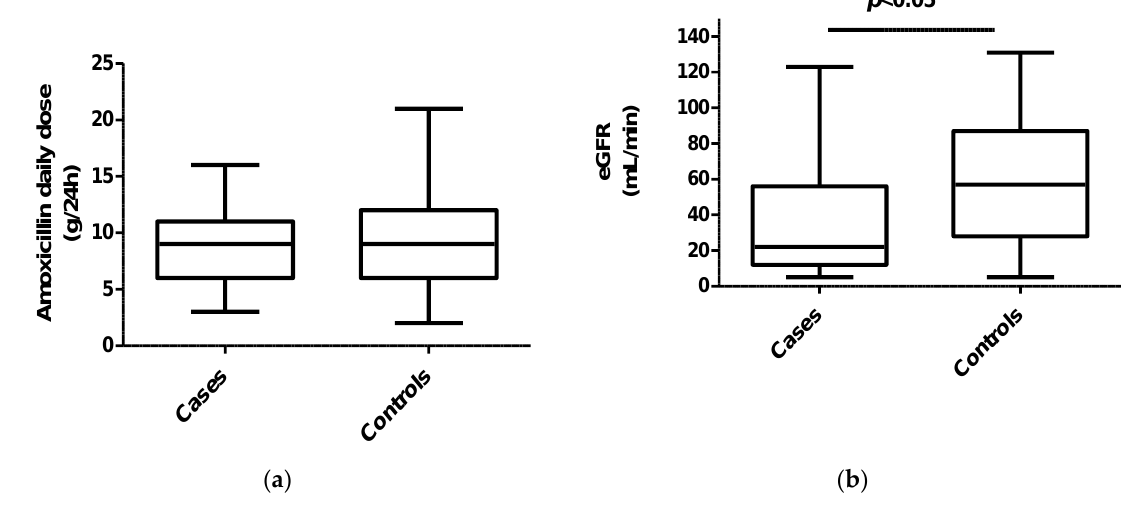
Figure 1. ( a ) Distribution of amoxicillin median daily dose (g), ( n = 86); ( b ) distribution of estimated glomerular filtration rate (mL/min), ( n = 101) for patients with neurotoxicity attributed (cases) and non-attributed (controls) to amoxicillin. Horizontal solid lines are the median.